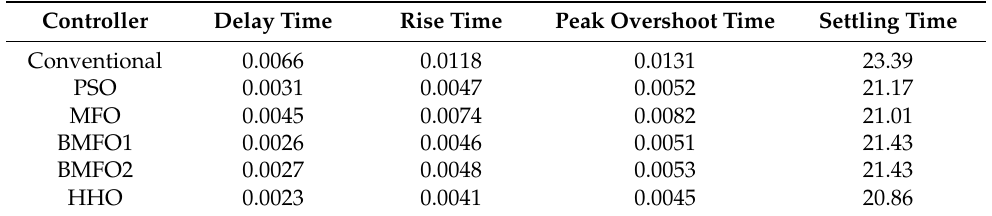
Table 16. Graph analysis of Area2 frequency with various controller under contract violation case.